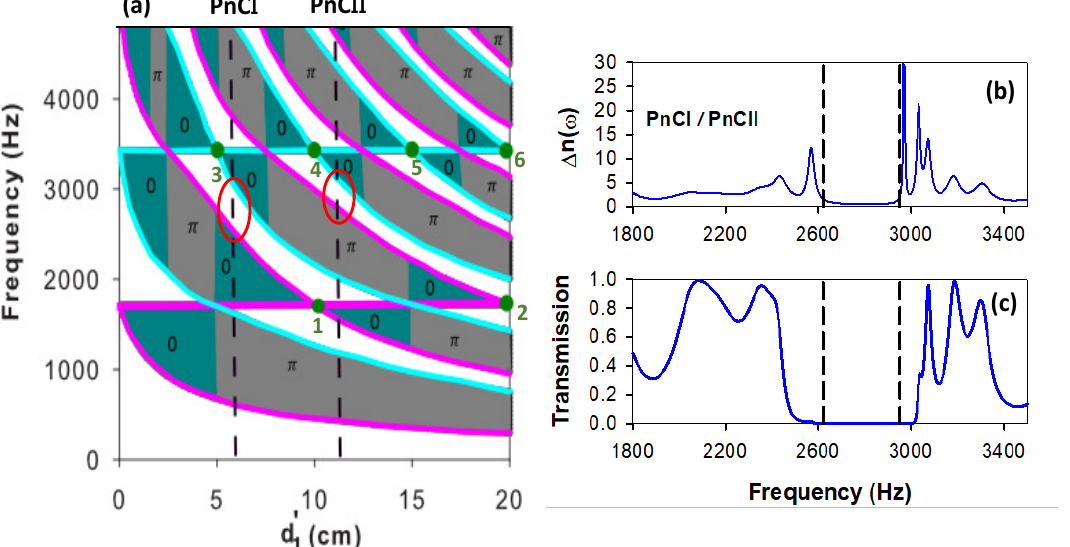
Figure 12. ( a ) Bandgaps (white area) separated by bands (shaded area) of an infinite PnC as a function of the length of the stub d (cid:48) , while the length of the period d 1 is fixed at 10 cm. The green circles labeled 1 1 to 6 indicate the positions of the band crossing points (where the dispersion curves become flat). The vertical dashed lines correspond to the two PnCs. Pink and cyan colors indicate the symmetric and antisymmetric edge modes of the common bandgaps, respectively. ( b , c ) DOS and transmission spectra for a finite PnC (Figure 1c) composed of two finite PnCs (PnCI and PnCII) with d (cid:48) = 12 cm and a fixed period d = d = 10 and d (cid:48) 2 1 2